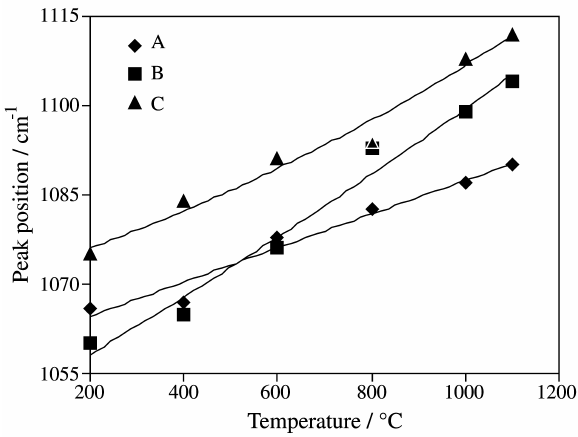
Figure 4. Asymmetric stretching mode of SiO 2 (ASTO) peak position as a functionoftemperature.Thelineswere drawn onlyasguideforthe eyes.